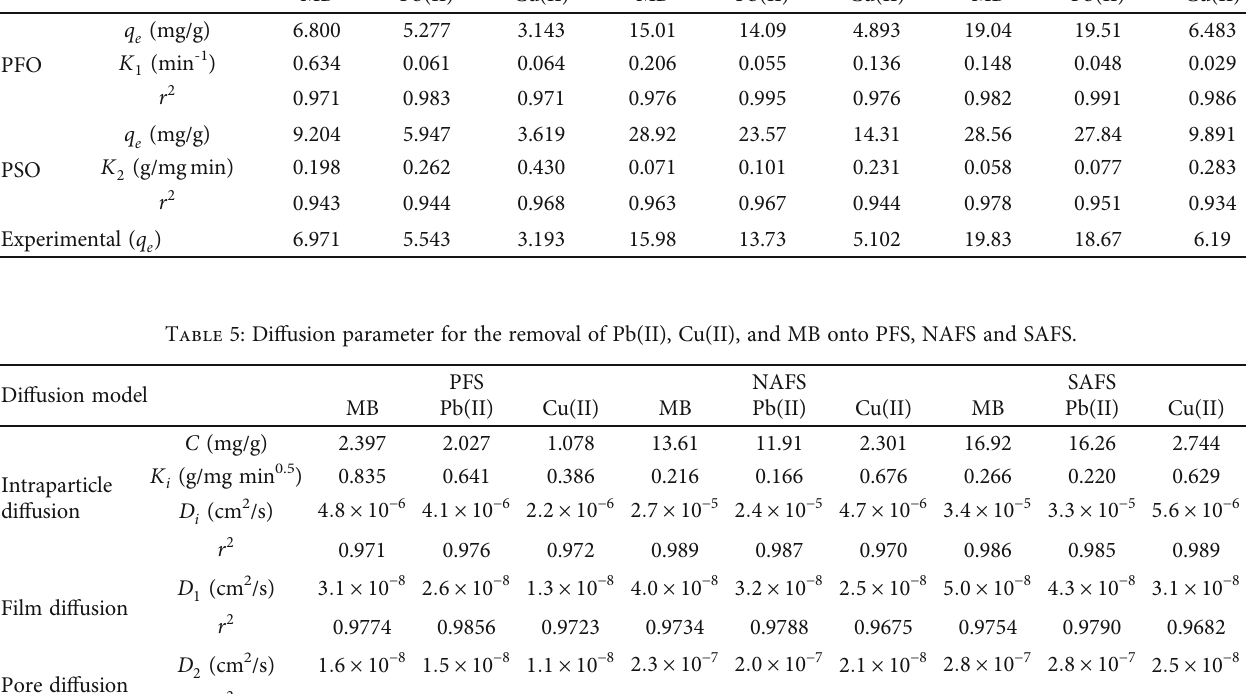
Table 4: Kinetic models for the adsorption of Pb(II), Cu(II), and MB onto pure (PFS) and treated (NAFS and SAFS) fennel seed adsorbents. Models